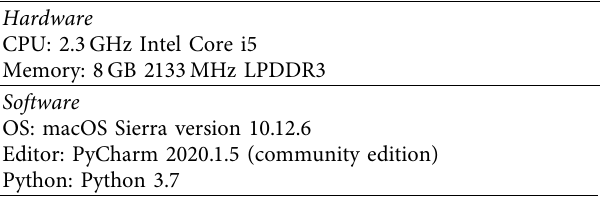
Table 1: Configuration of the experimental